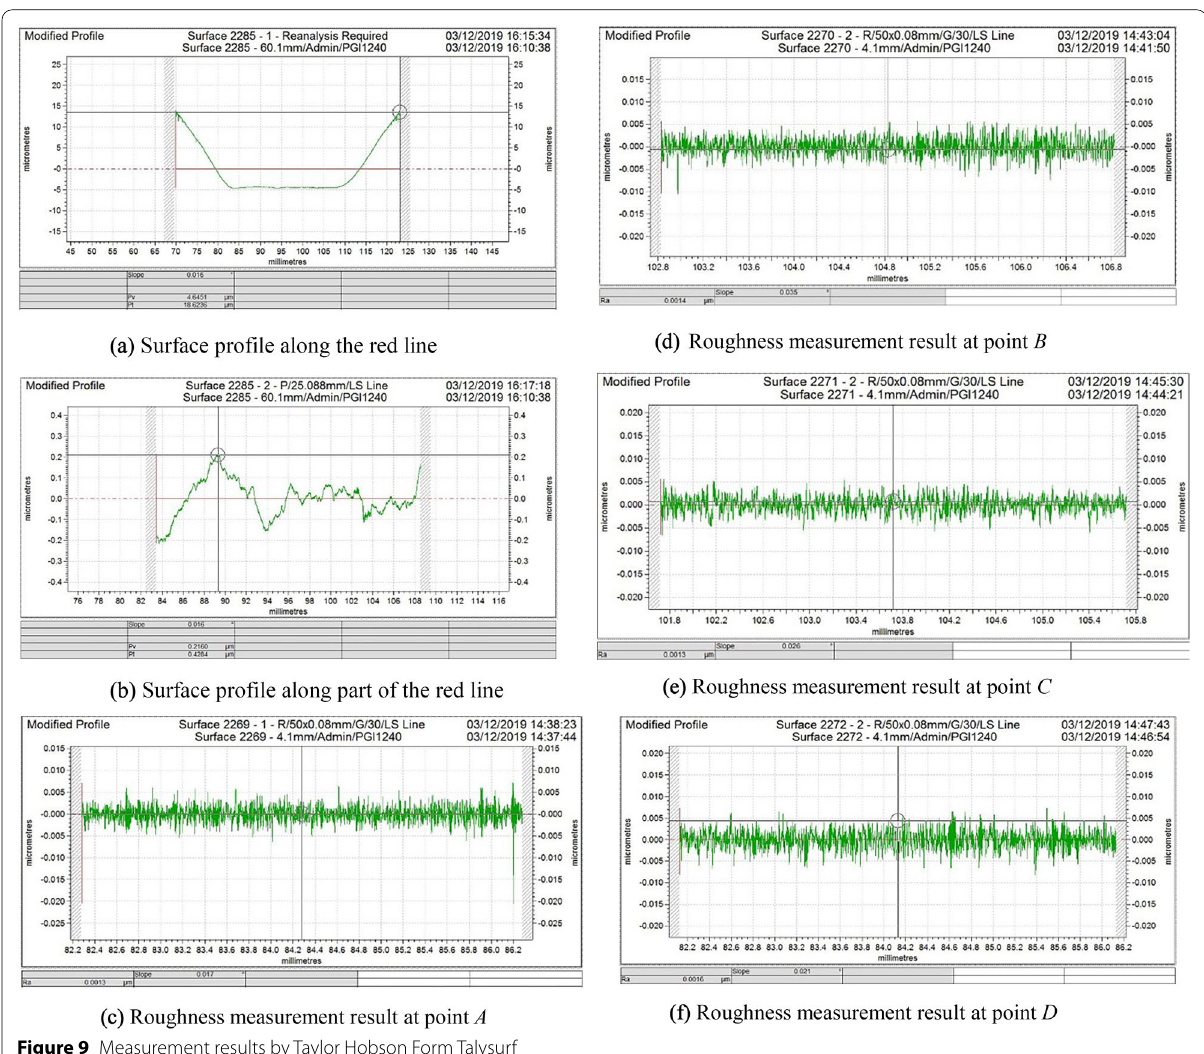
Figure 9 Measurement results by Taylor Hobson Form